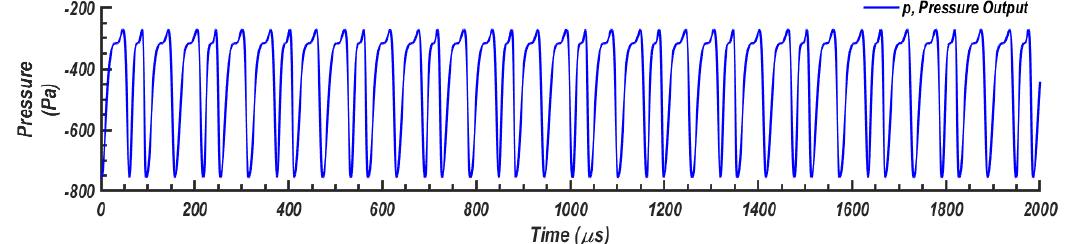
Figure 6. The output static pressure signal as obtained from numerical simulations and used in the NARMAX construction.